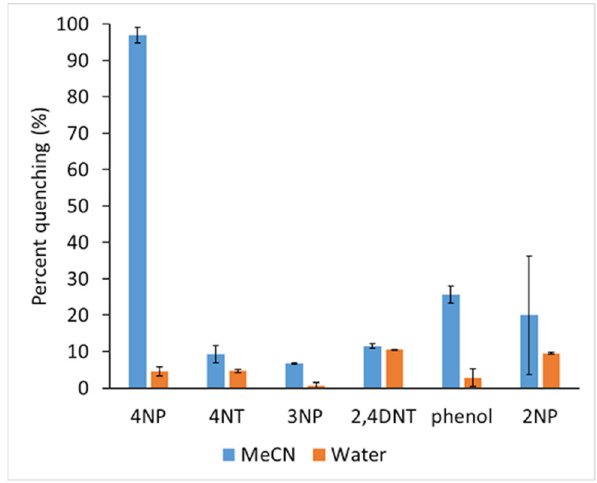
Figure 7. Percentage of fluorescence quenching of NaFl in presence of nitroaromatic in MeCN and in water. in